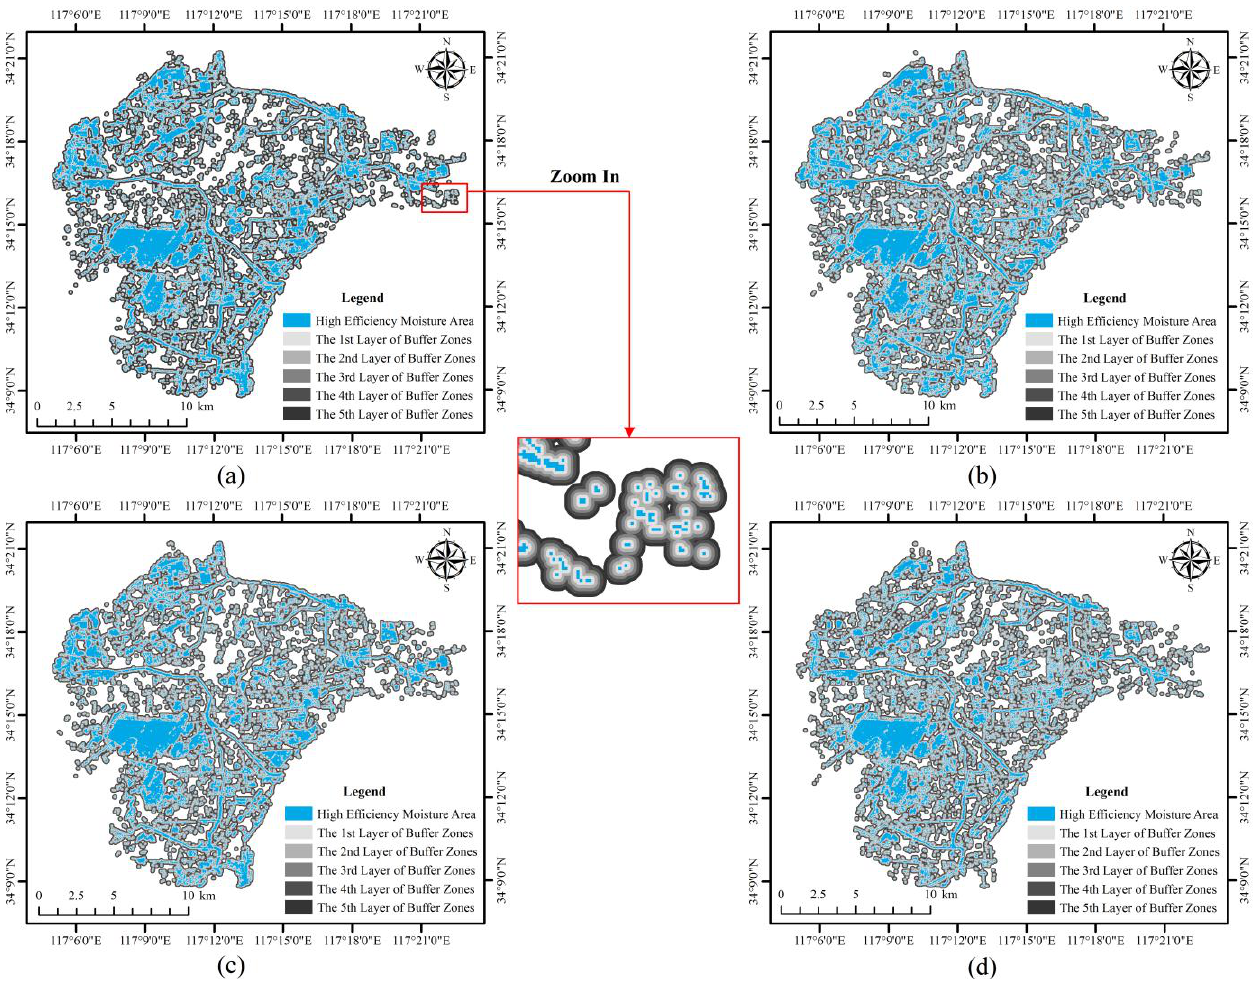
Figure 6. ( a ) Buffer zones of “High Efficiency Moisture Areas” on 21 May 2013; ( b ) 3 September 2013; ( c ) 1 May 2014; ( d ) 22 September 2014. 3.2.2. The Regression Analysis between the Changes of LST and ULSM in “High Efficiency